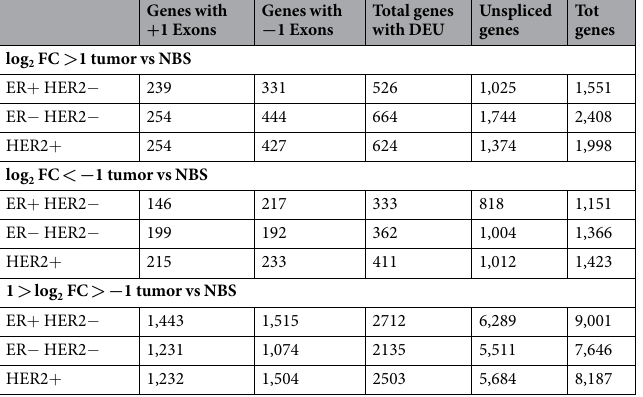
Table 2. Number of genes with differential exon usage in genes with higher, lower, and similar expression in the three clinical subtypes compared to NBS.